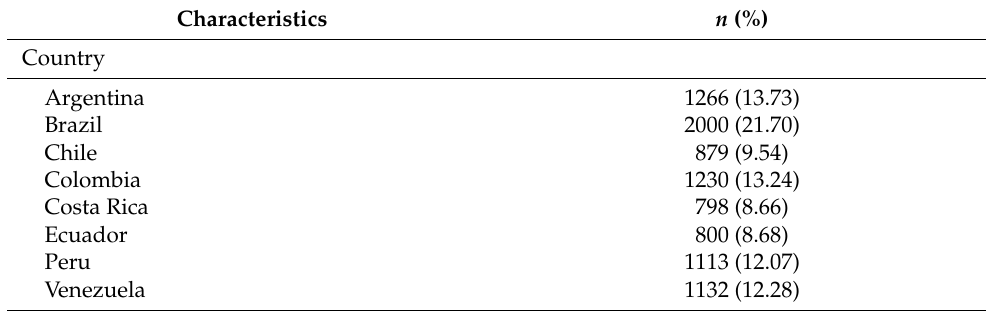
Table 1. Demographics and lifestyle characteristics of the Latin American population. Latin